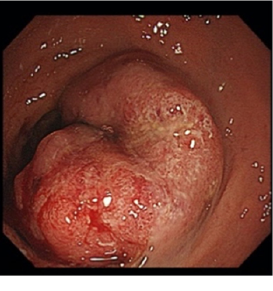
( b ) Figure 2. Basics concepts of AI, ML, and DL. ( a ) The relationships of AI, ML, and DL; ( b ) The work- flows of ML and DL. 2.2. Data Modality